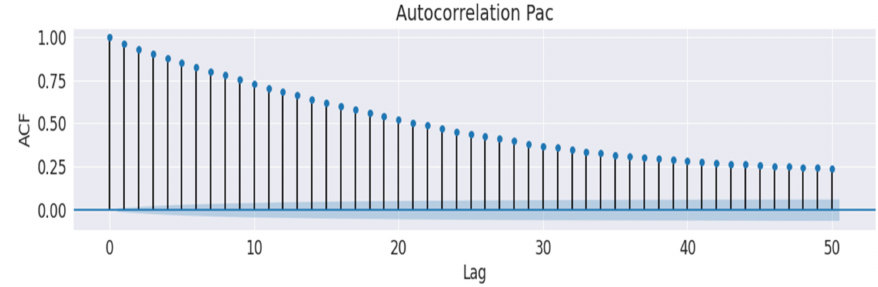
Figure 1. Autocorrelation in Power AC (Pac).